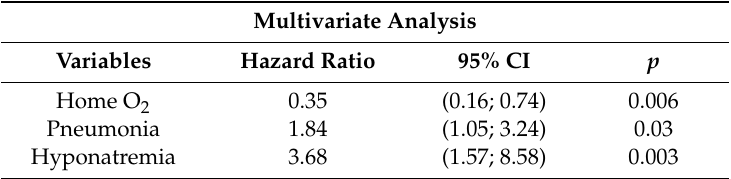
Table 6. Factors related to poor progress following admission for